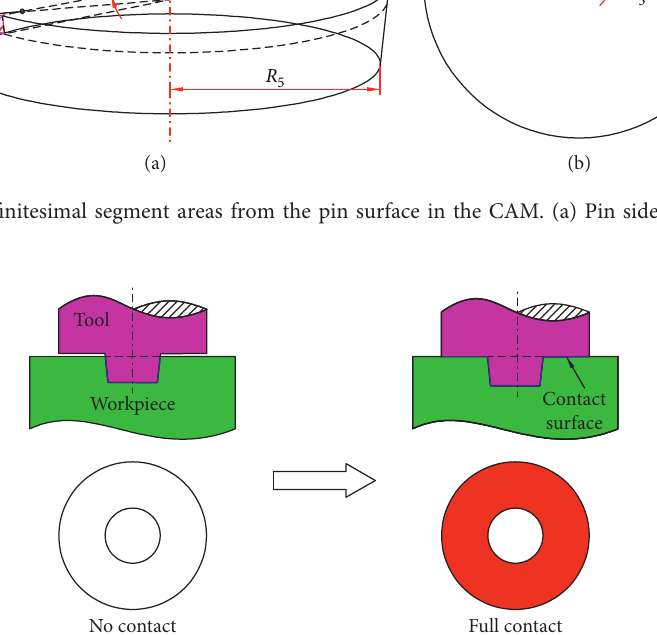
Figure 8: Contact conditions between the shoulder and workpiece in the shoulder-plunging stage at different steps in the CAM.